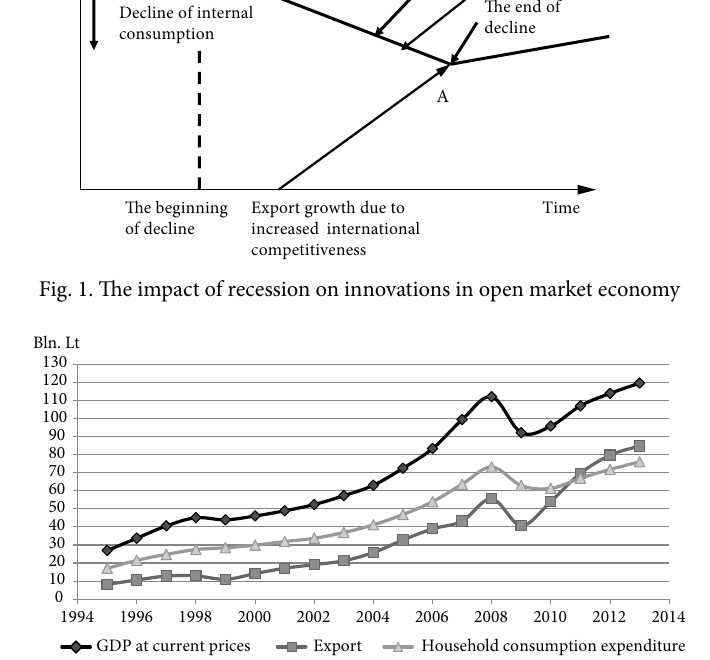
Fig. 2. Changes of GDP at current prices, export and household consumption expenditure in Lithuania Source: authors’ calculations based on the Statistics Lithuania data (2015).